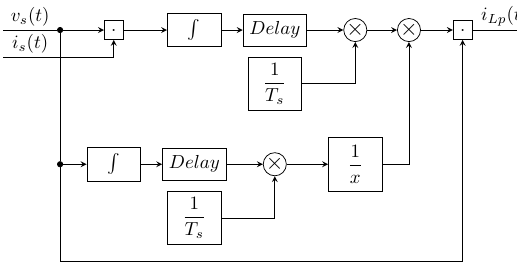
Figure 8. Block diagram of Cross-Correlation